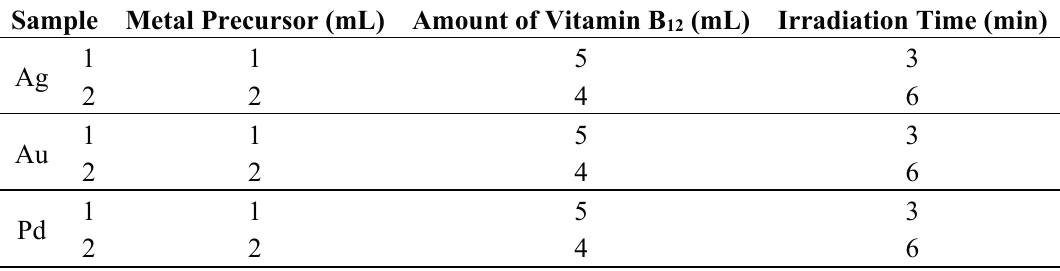
Table 1. Experimental conditions for the synthesis of Ag, Au, and Pd a